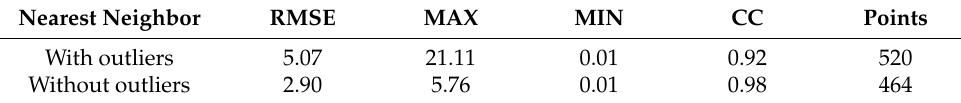
Table 4. The displacement comparison between PS results and leveling (unit: mm).